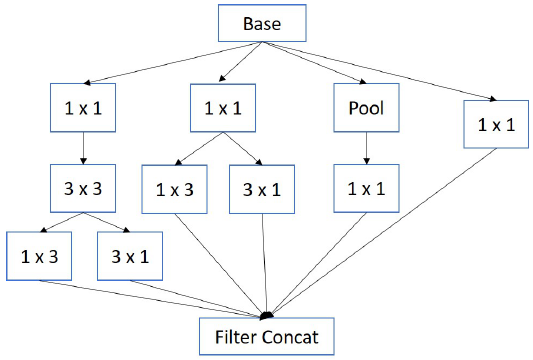
Figure 3. Example of inception module in CNN architectures.